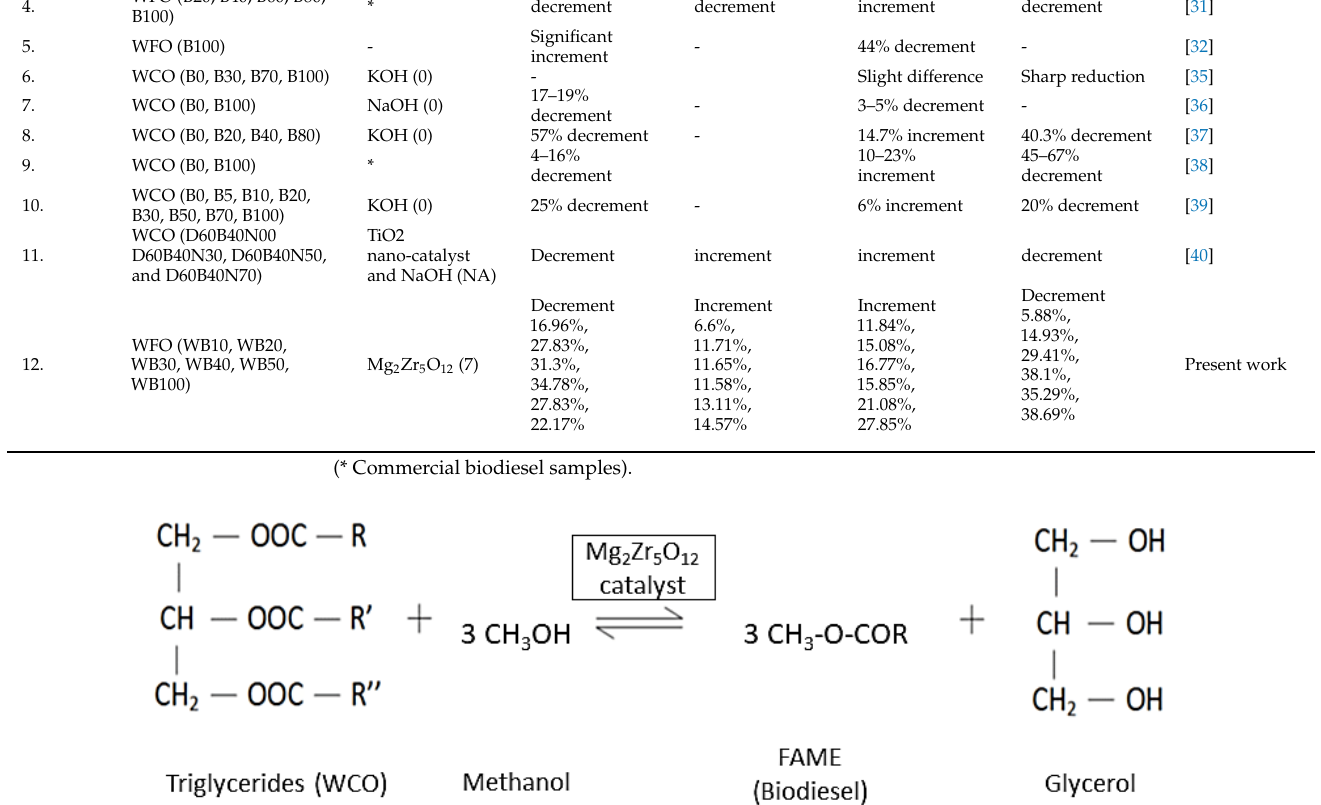
Figure 11. Transesterification reaction of WCO biodiesel.